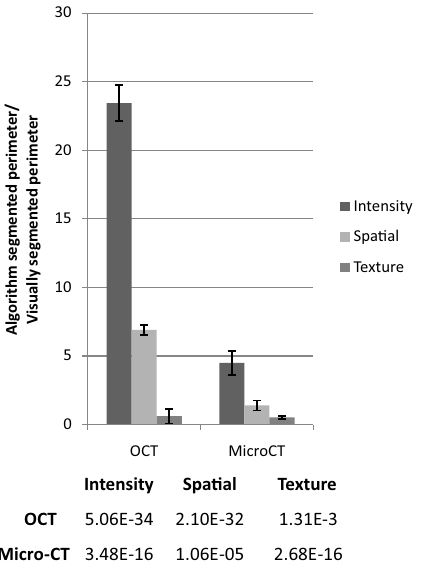
Fig. 6. Average perimeter of tumor found by each method normalized to visual segmentation (training dataset, n ¼ 25) with error bars representing standard deviation. A Student's t -test comparing the mean of perimeters found by each method with the perimeter obtained by visual inspection was per- formed. The p -values are shown in the table. Note, because the data is normalized, perimeters closer to 1 more closely approach the perimeter determined by visual segmentation.